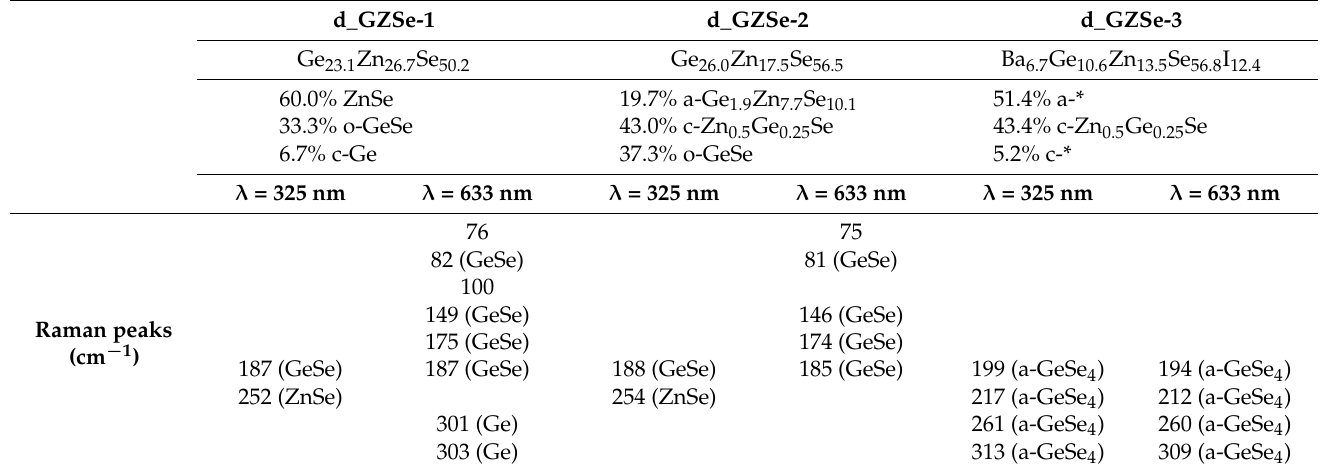
Table 5. The peaks positions in the Raman spectra for the three mirror-polished chalcogenide sintered bulks, when irradiated with monochromatic radiation with a wavelength of 325 nm and 633 nm. The intended composition (where coefficients are in wt. %) and the percentage (wt. %) of each phase are also presented.